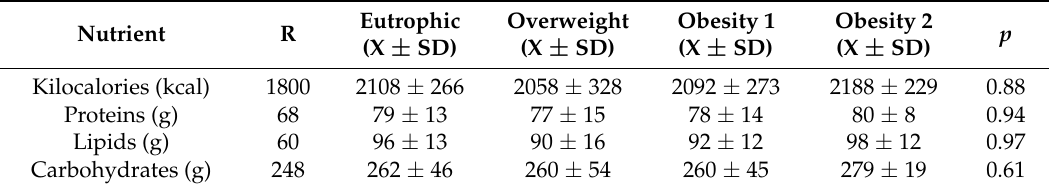
Table 2. Intake of macronutrients.